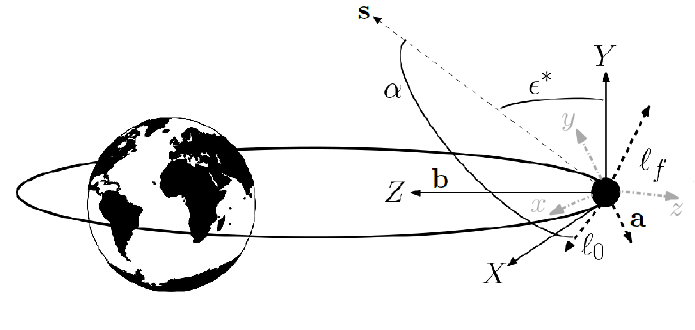
Figure 1. The inertial LVLH frame (X,Y,Z) and the body fixed frame ((x,y,z) shown in grey) with the telescope boresight initial and final directions (cid:96) 0 and (cid:96) f